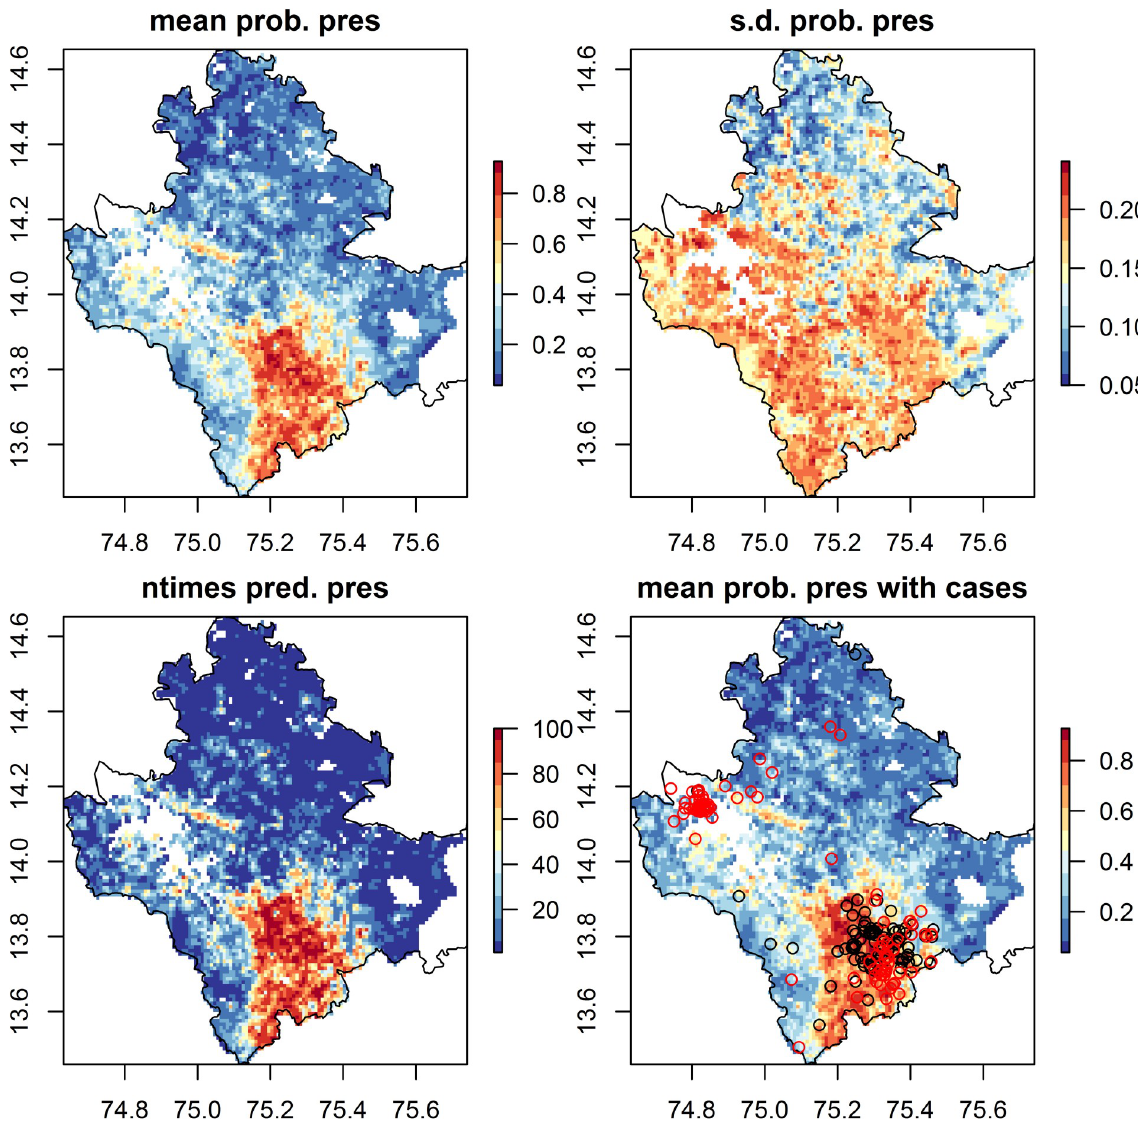
Fig 5. Predicted probability of presence of KFD from Boosted Regression Tree models containing landscape predictors (without forest loss) at a 1 km resolution. Top panels give mean and standard deviation of the relative predicted probability of presence of KFD in each grid cell across model runs. Top left panel—areas in orange and red have a higher predicted probability of presence of KFD, whilst areas in blue have a lower predicted probability of presence of KFD. Top right panel–areas in yellow and red have more variable predictions of probability of presence of KFD than blue areas. Bottom left panel indicates the number of times KFD is predicted to be present in each cell across the 20 model runs, with orange and red indicating that KFD is often predicted to be present. Bottom right panel again depicts the mean predicted probability of presence but the locations of affected households are super-imposed, for the 2014 to 2018 seasons as open black circles and for the 2018 to 2019 season as open red circles. These raster maps are not under copyright since they are a product of this study. The administrative boundary dataset is from HindudstanTimesLabs (https://github.com/HindustanTimesLabs/shapefiles/), reproduced under the MIT License. Human case data are from Department of Health and Family Welfare Services, Government of Karnataka. White areas in Bhadravathi taluka in south east corner indicate no